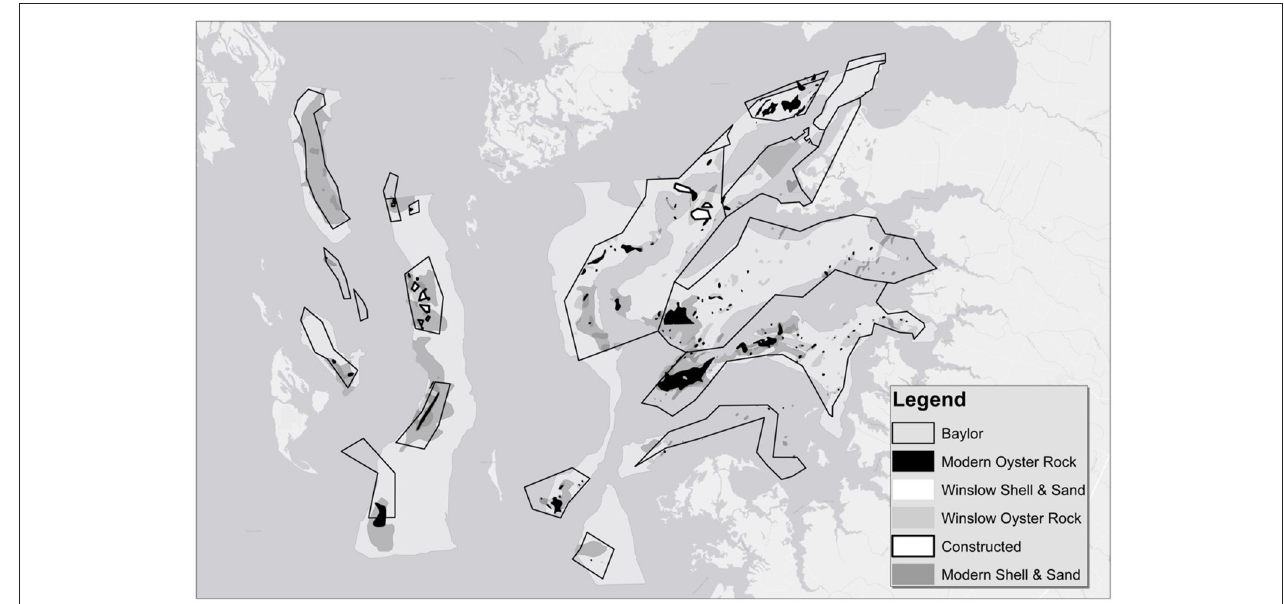
FIGURE 9 | Map showing Baylor (1895) grounds (polygon outlines), Winslow (1882) survey (medium grey = Winslow oyster rock, very pale grey = Winslow shell and sand, and Haven et al. (1981) survey (black = Modern oyster rock, dark grey = Modern shell and sand, bright white polygons are